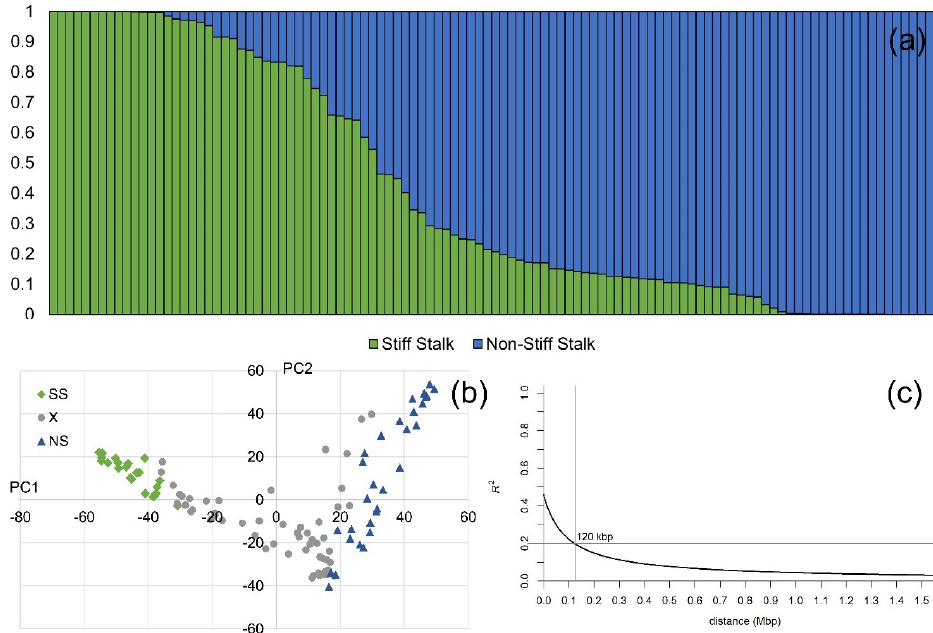
Figure 1. Genetic properties of the 109 genotyped-by-sequencing (GBS) genotyped maize inbred lines: ( a ) Q matrix from STRUCTURE analysis assigning the inbred lines to two groups: Stiff Stalk (SS) and Non-Stiff Stalk (NS); (b) results of principal component (PC) analysis using 40777 SNPs—marked green and blue are the lines with Q > 0.9 for SS and NS, respectively; ( c ) linkage disequilibrium decay across all chromosomes.